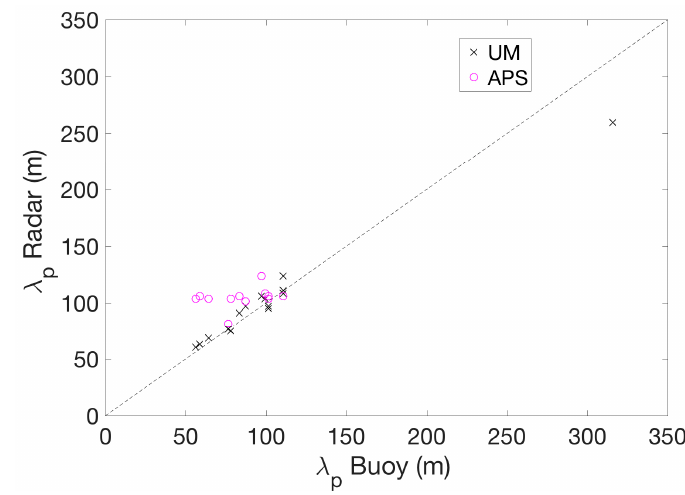
Figure 8. Scatterplot of λ p derived from the APS radar ( ) and UM radar ( ✖ ) POD orbital velocity reconstructions versus the buoy-based λ p . The dashed line shows the 1:1 line for reference.